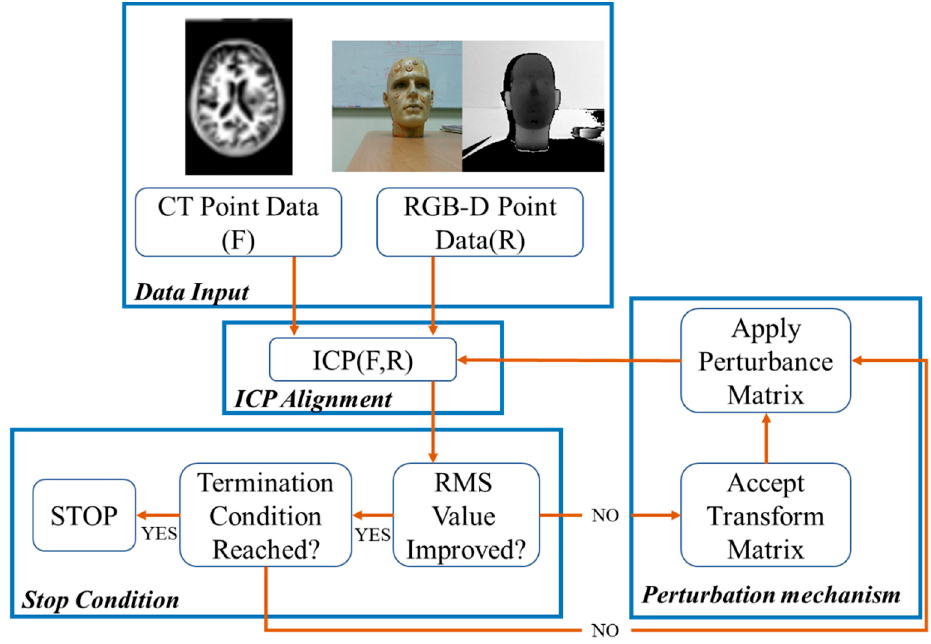
Figure 2. The flowchart of I-ICP alignment algorithm.